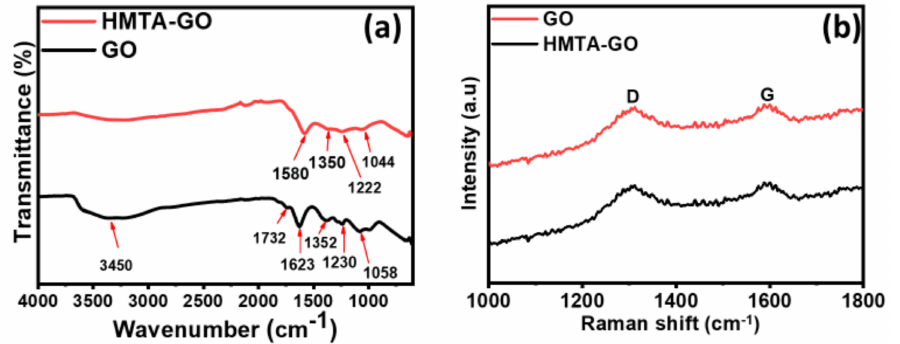
Figure 1. ( a ) FTIR ( b ) Raman spectra of GO and